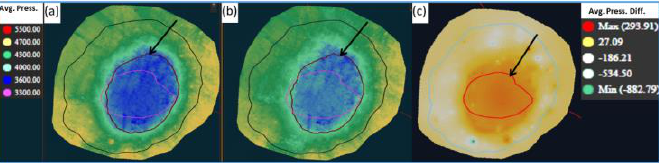
Figure 12. Reservoir performance over time—average pressure changes. ( a ) 1994 baseline, ( b ) 2014